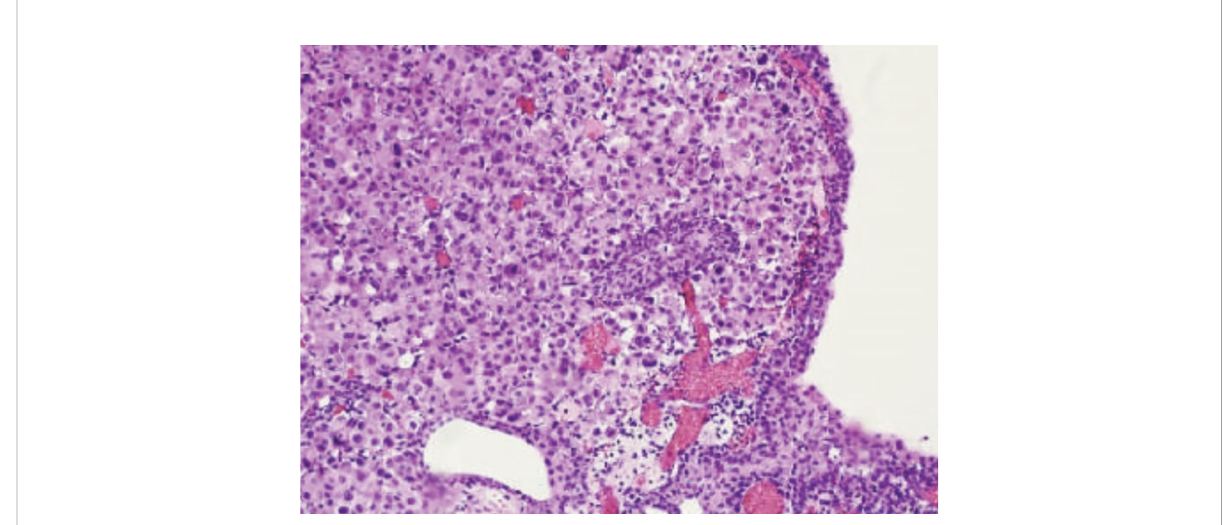
FIGURE 1 Hematotoxylin-eosin coloration (20x) showing the submucosal layer of the urinary bladder invaded by poorly differentiated, atypical cells with deep in fi ltration of the muscolaris propria. Urothelial mucosa is completely